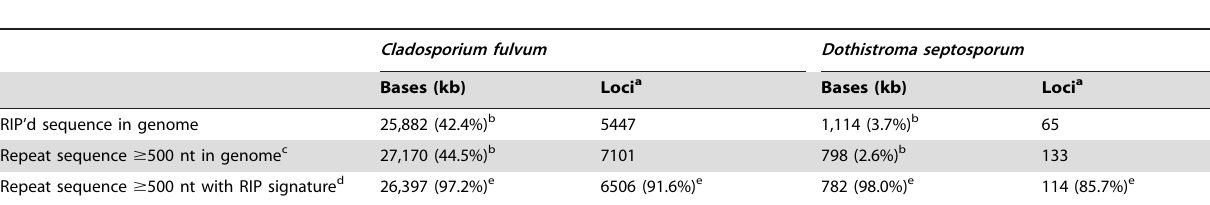
Table 3. Occurrence of Repeat-Induced Point Mutation (RIP) signatures and repeats in C. fulvum and D. septosporum